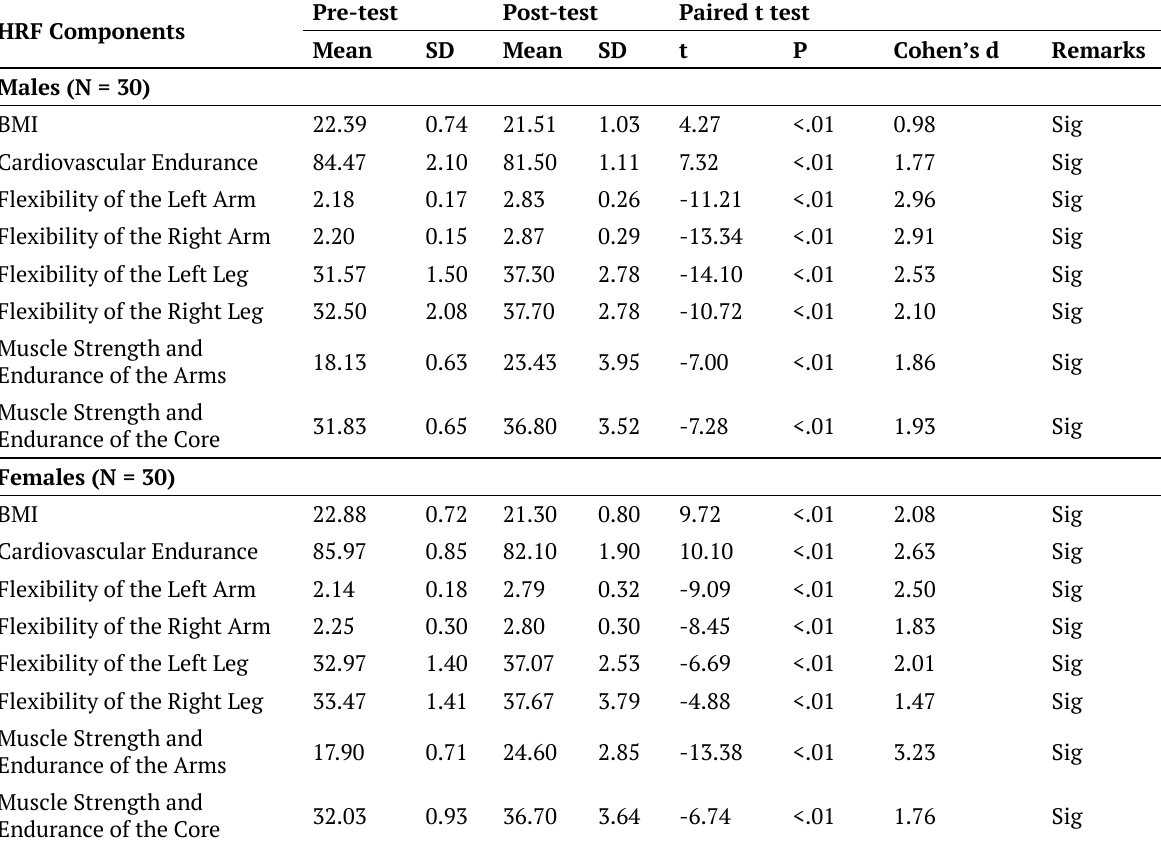
Table 2. Significant difference of the Pre- test and post-test scores of participants (male vs. male, female vs. female) in the CE group Pre-test Post-test Paired t test HRF Components